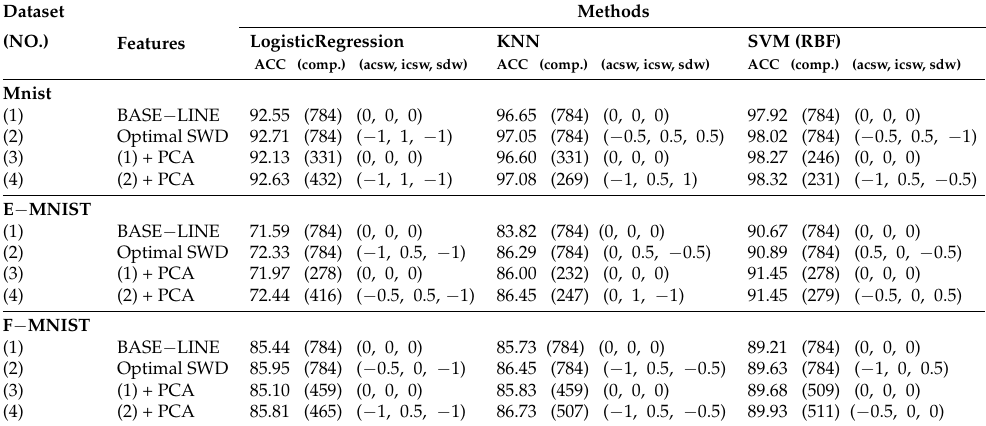
Table 4. The comparison accuracy of statistically weighted dimension feature based on PCA analysis. The value before the parentheses is accuracy of classification, the value in first parentheses is the number of components, and the value in last parentheses is the number of exponents for ACSW , ICSW , and SDW . Dataset